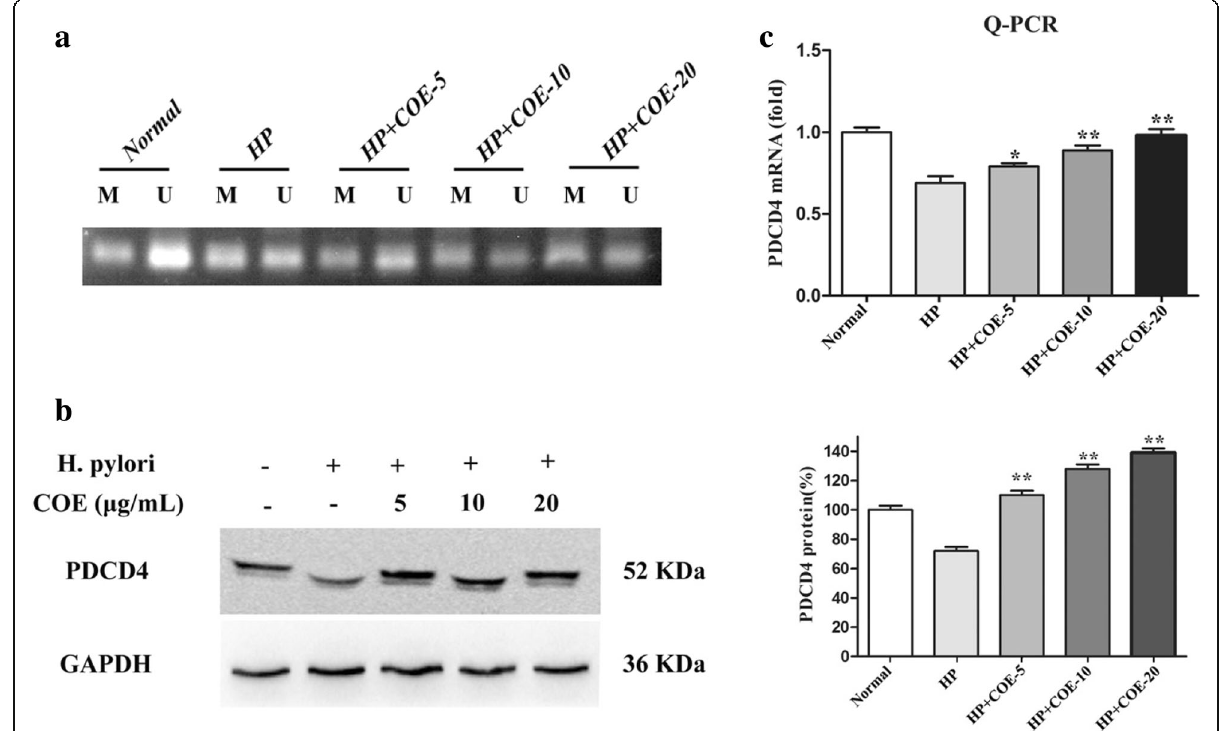
Fig. 4 Effect of COE on H. pylori infection-induced methylation status and expression of PDCD4 gene. ( a ) The methylation status of the PDCD4 promoter induced by COE determined via the MSP assay. U-non-methylated product; M-methylated product. ( b ) PDCD4 protein levels after COE treatment was detected by western blot analysis. The relative density was normalized to GAPDH, which was determined by densitometric analysis. ( c ) PDCD4 mRNA levels after COE treatment was detected by RT-PCR. The data was analyzed using the 2 - ΔΔ Ct method. Each experiment from three independent experiments and values are expressed as means ± SD of three independent experiments. * P < 0.05, ** P < 0.01, compared to H. pylori infection-induced group